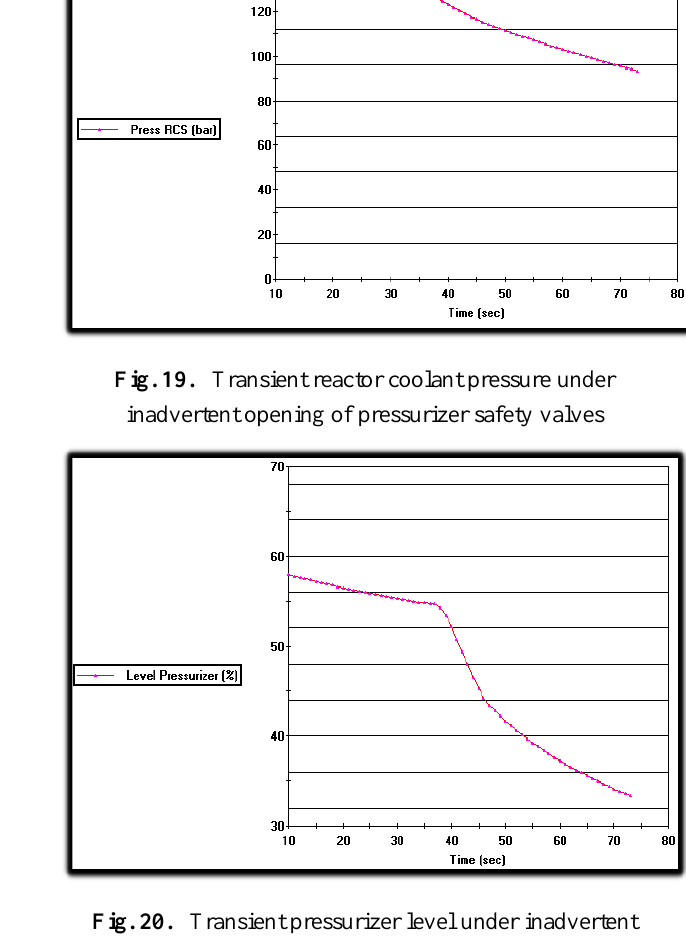
Fig. 20. Transient pressurizer level under inadvertent opening of pressurizer safety valves